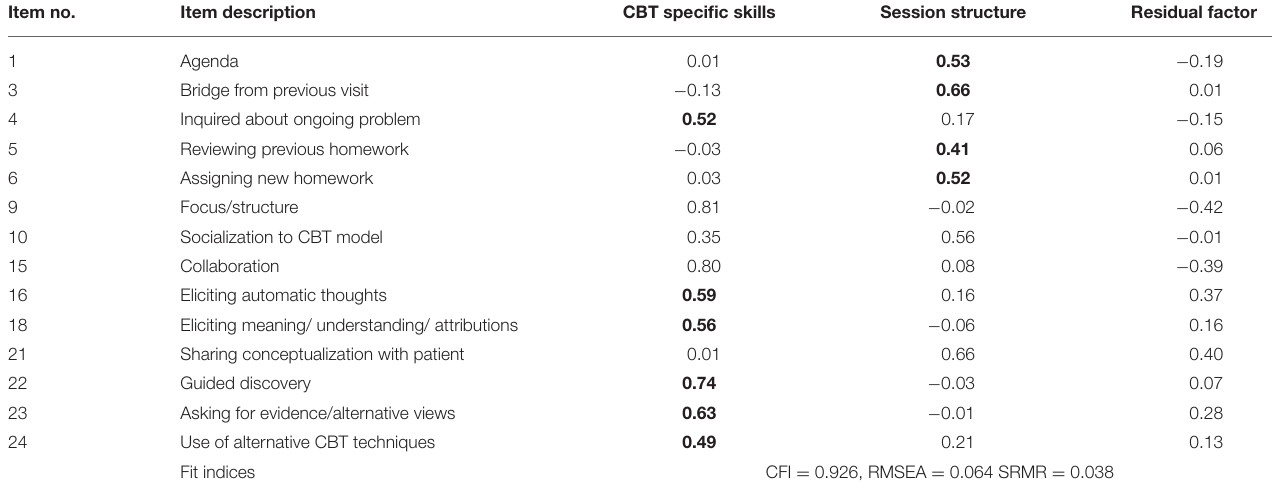
TABLE 3 | Summary of complex exploratory factor analysis, standardized ( n = 333). Item no.